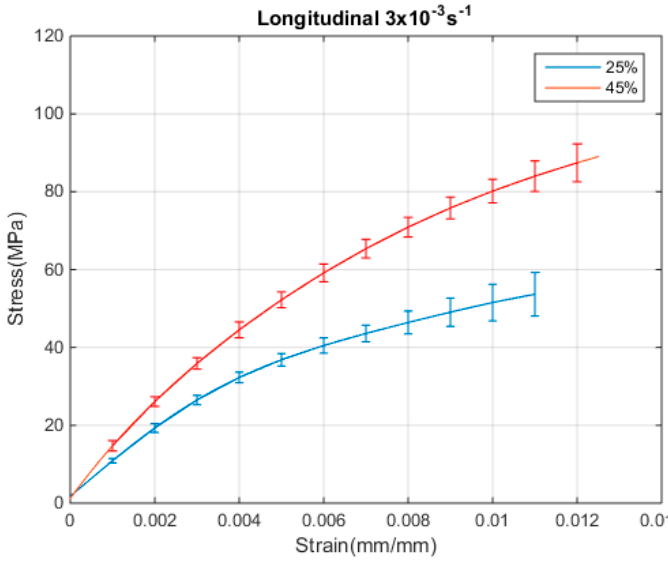
Figure A1. Longitudinal 25% and 45% 3 × 10 − 3 s − 1 Results with Standard Deviation Error Bars.